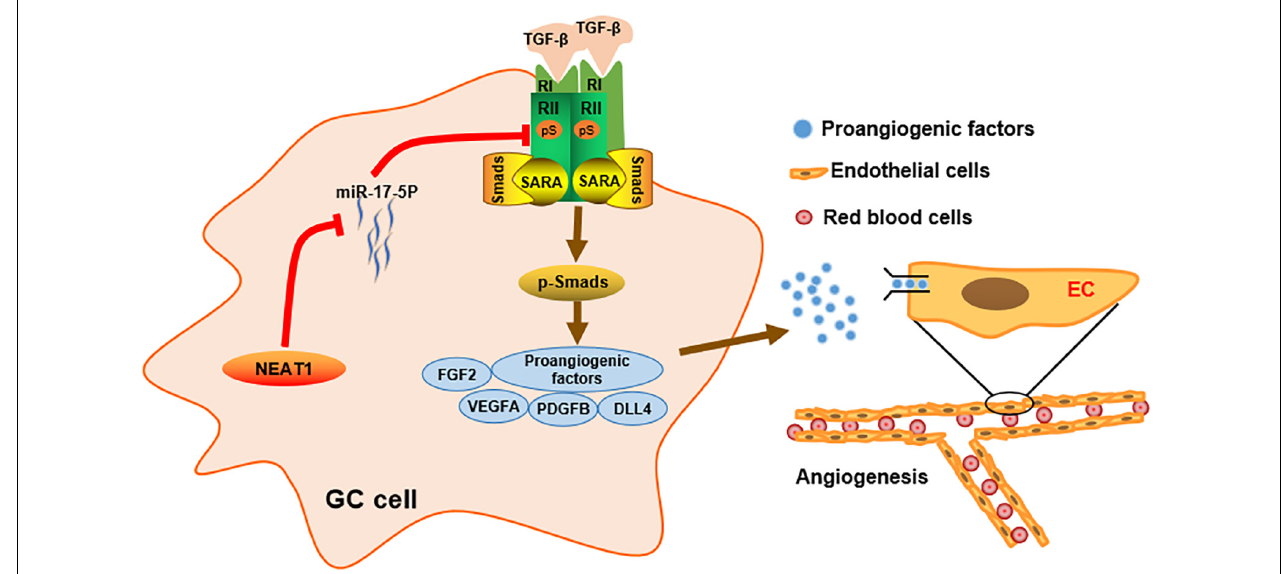
FIGURE 6 | Schematic diagram of the mechanism of LncRNA NEAT1 mediated angiogenesis in gastric cancer.